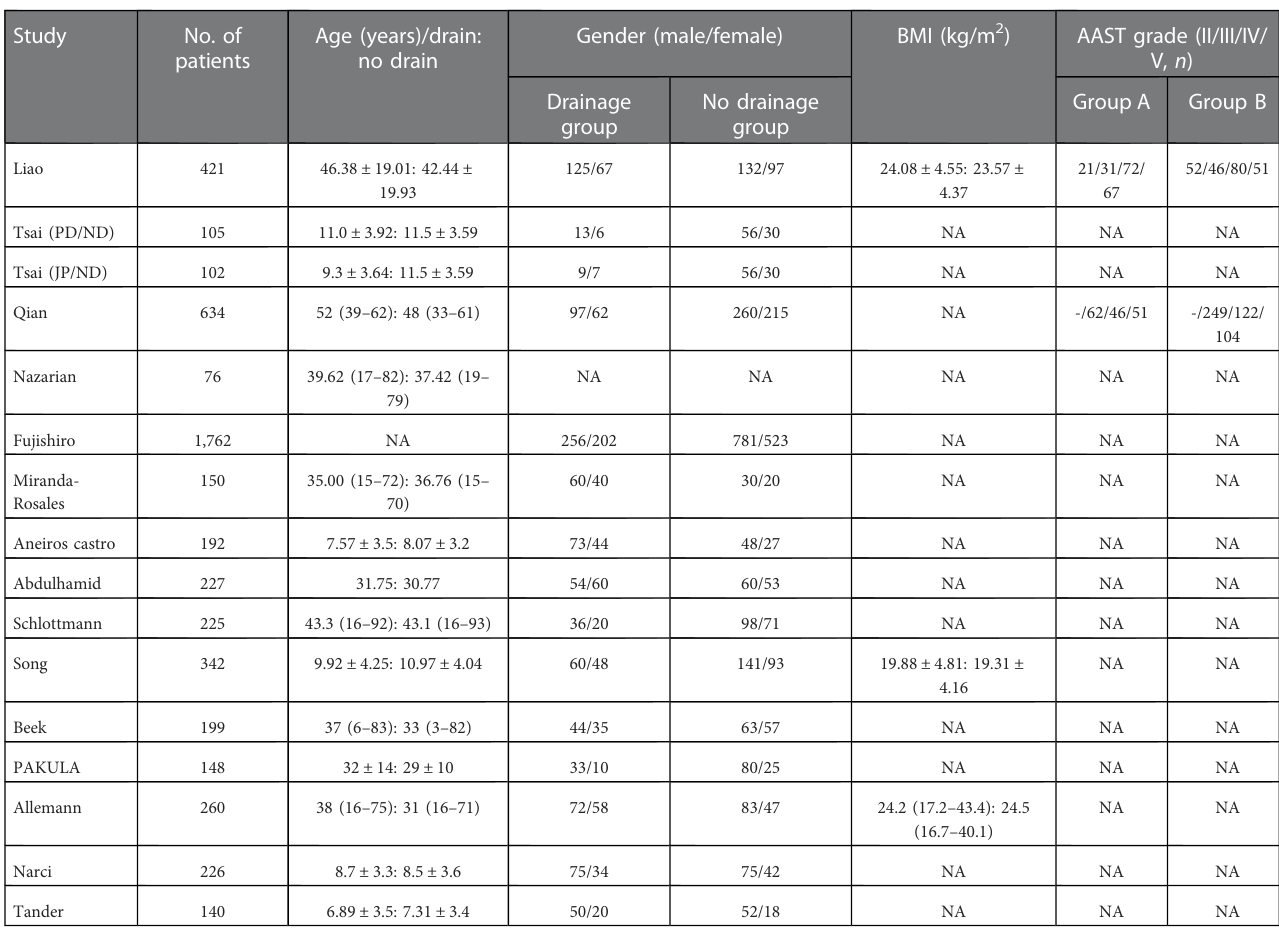
TABLE 2 Demographic results of patients of included studies.